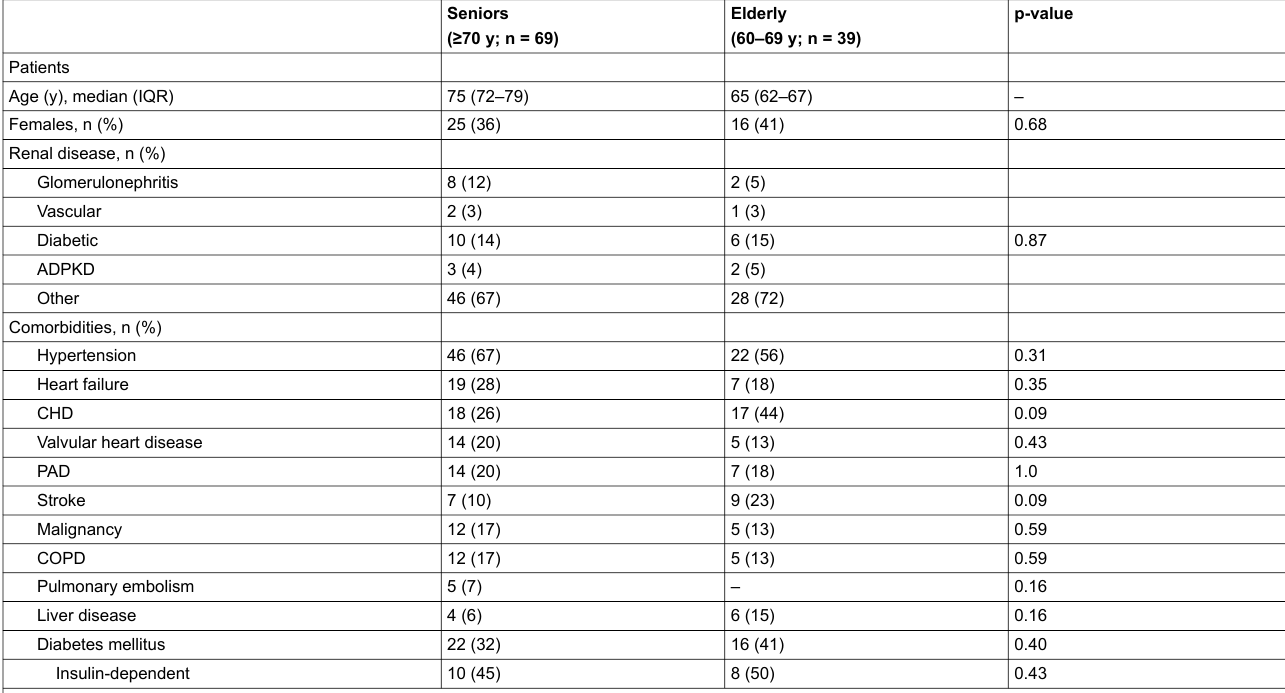
ADPKD = adult polycystic kidney disease; CHD = coronary heart disease; COPD = chronic obstructive pulmonary disease; PAD = peripheral artery